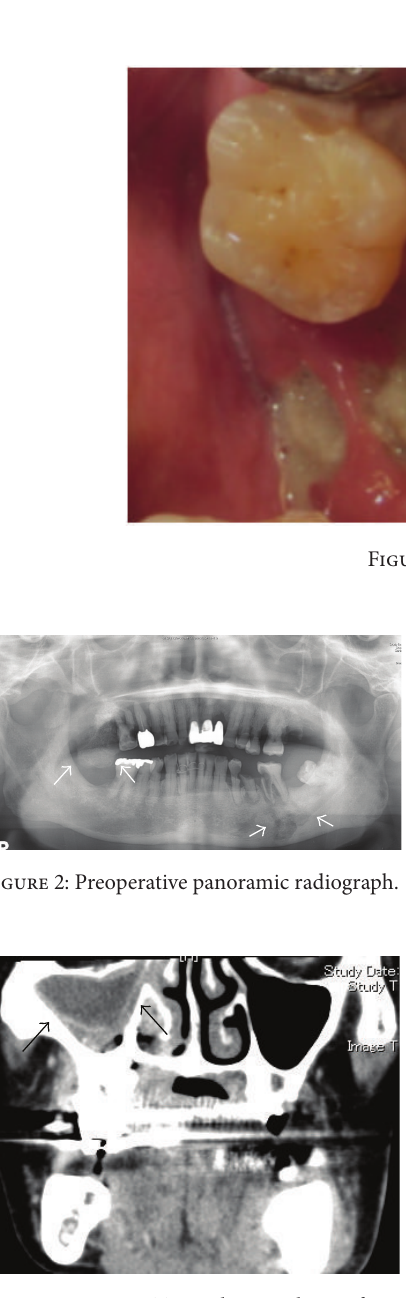
Figure 3: Preoperative CT revealing an abscess formation.